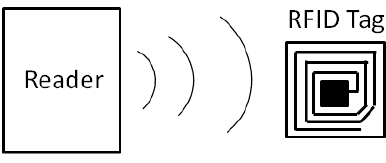
Figure 7. RFID tag and reader.